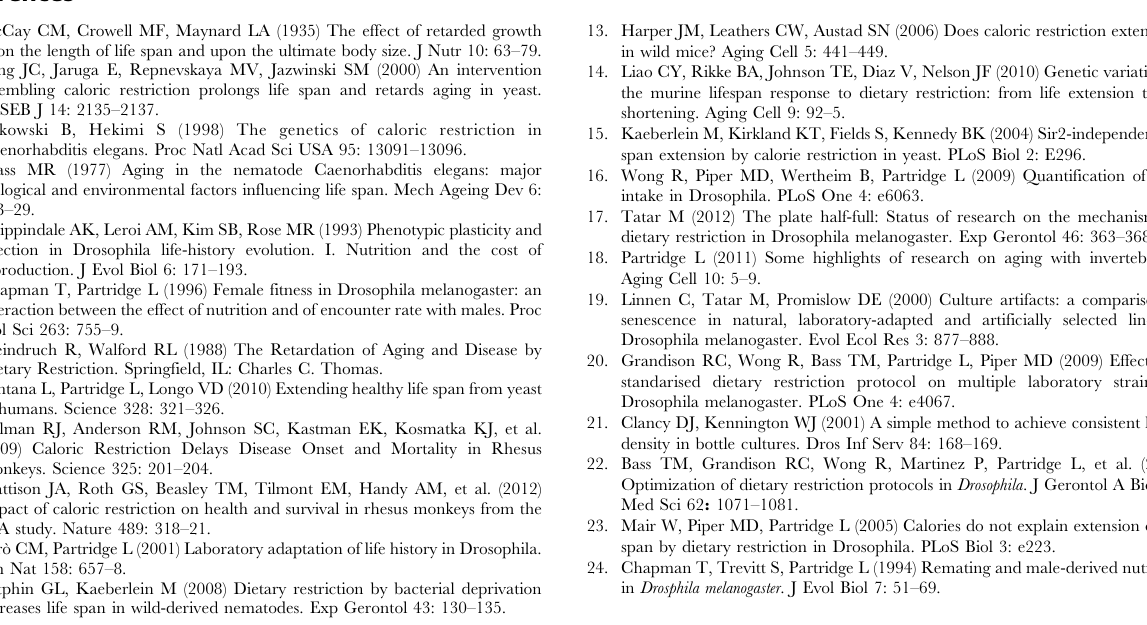
Table S1 Statistical significance of DR-mediated chang- es in fecundity and lifespan of Drosophila melanogaster strains. The yeast concentration from 0.5 to 0.1 is excluded from the DR range estimation. For fecundity a Student’s two-tailed t- test was used. For lifespans a Log Rank test was used. The statistically significant values are shown in italics ( n = 100, significance level: p ,